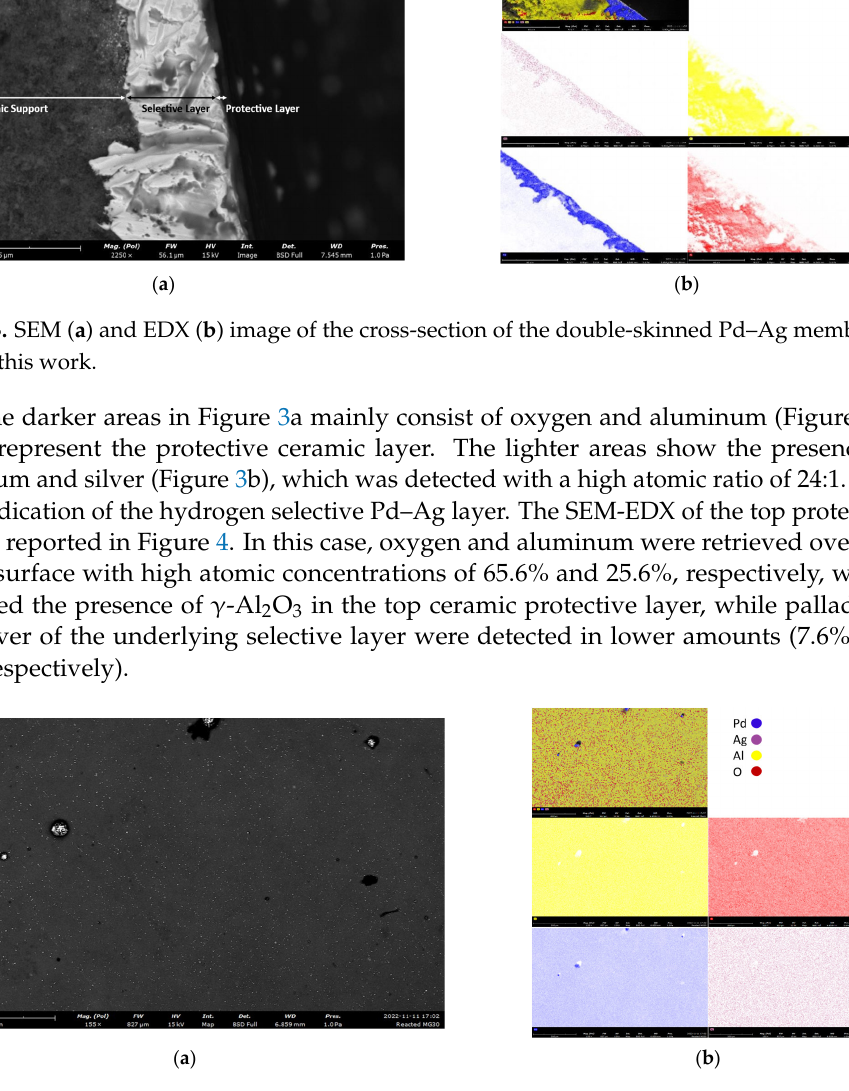
Figure 4. SEM ( a ) and EDX ( b ) image of the top layer of the double-skinned Pd–Ag membrane used in this work. in this